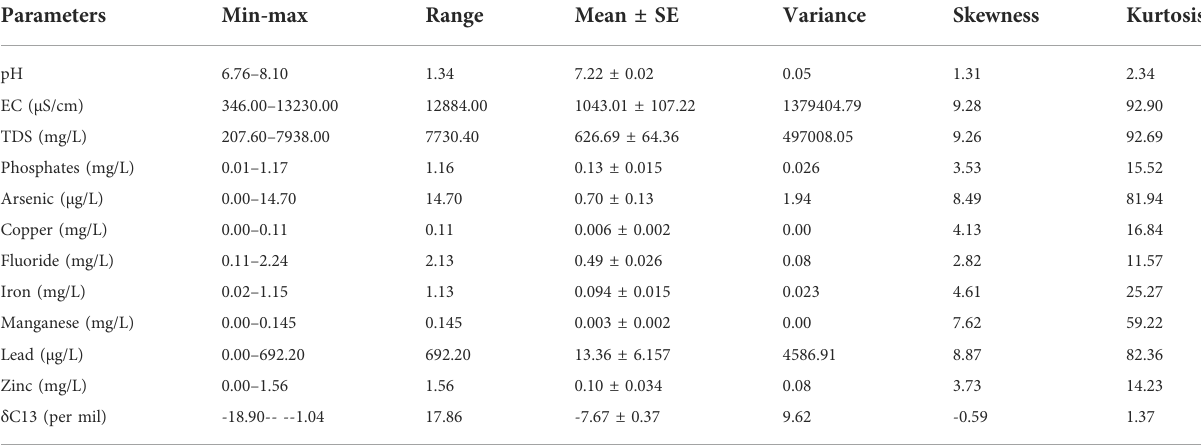
TABLE 1Statisticalsummaryof the physiochemical,heavy metal, and stable carbonisotope composition in groundwatersamplesof the “ twin cities.